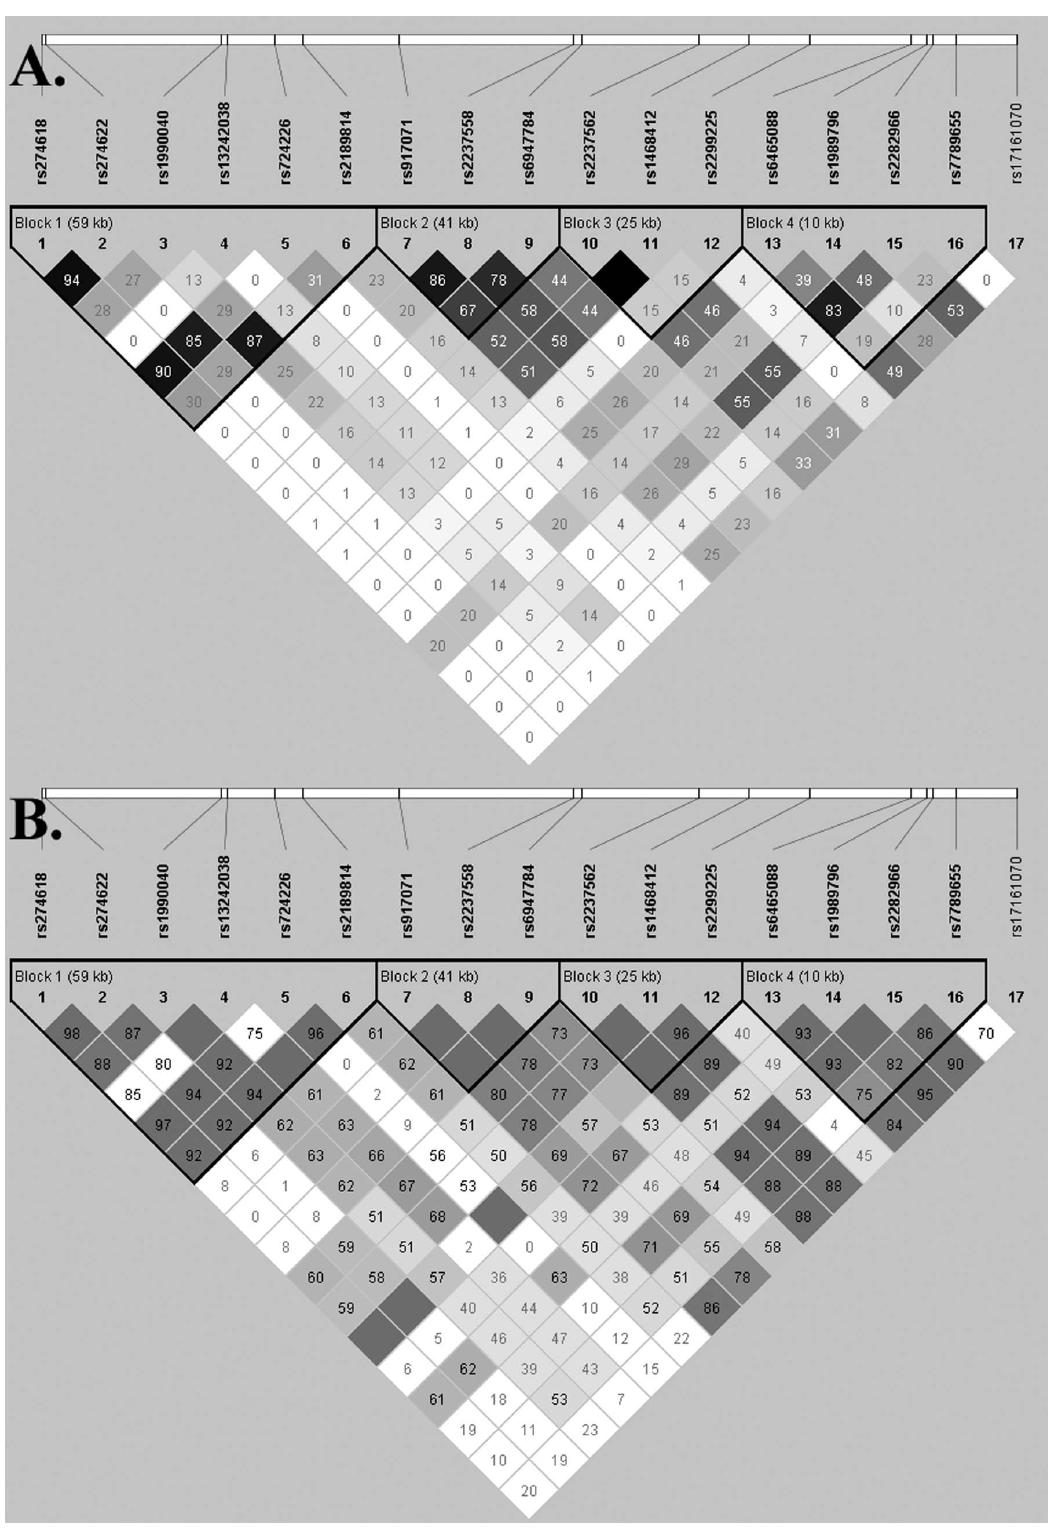
Figure 3. Linkage disequilibrium (LD) plot of 17 GRM3 SNPs in healthy controls. In figure A, the r 2 6 100 value corresponding to each SNP pair is shown in the square; black squares indicate r 2 =1, i.e., complete LD; white squares indicate r 2 =0; shaded grey squares indicate 0 , r 2 , 1. In figure B, D 9 6 100 value corresponding to each SNP pair is shown in the square; white squares indicate D 9 , 1 and LOD , 2; blue squares indicate D 9 =1 and LOD , 2; shaded red squares indicate D 9 , 1 and LOD $ 2; bright red squares indicate D 9 =1 and LOD $ 2.